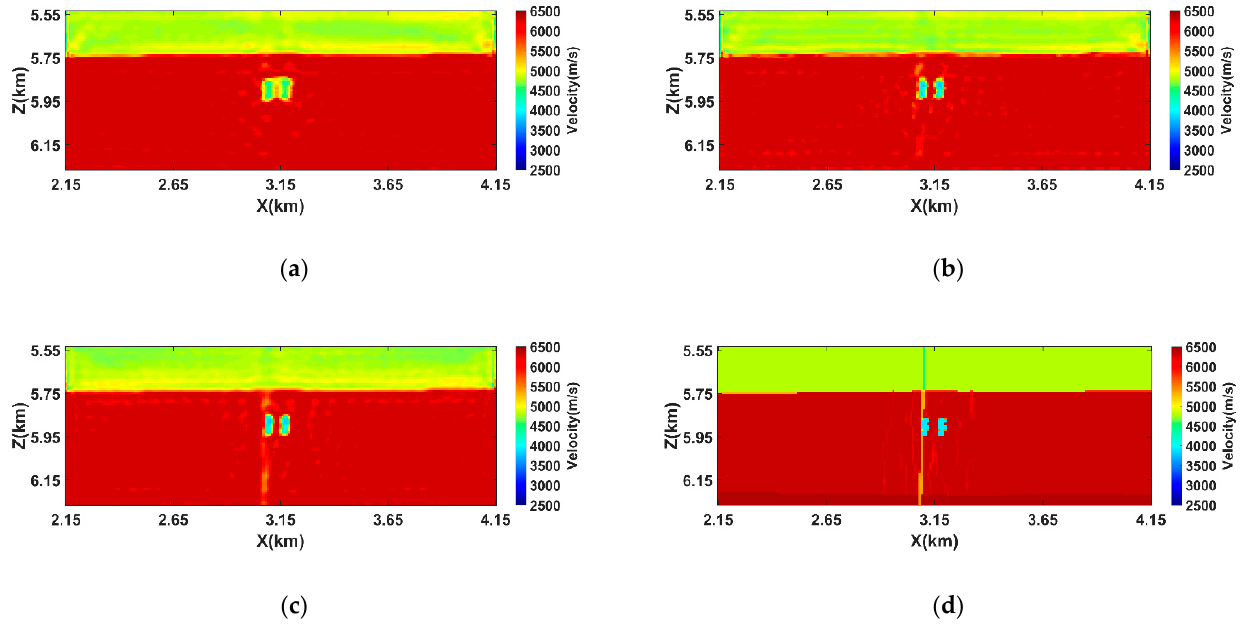
Figure 10. Comparison of local FWI results using different methods with ( a ) local FWI based on standard Marchenko receiver redatuming. ( b ) VSP and surface data jointed local FWI based on VSP data jointed Marchenko source-receiver redatuming. ( c ) Local FWI using modeling subsurface wavefield as a reference. ( d ) True local model as a benchmark.